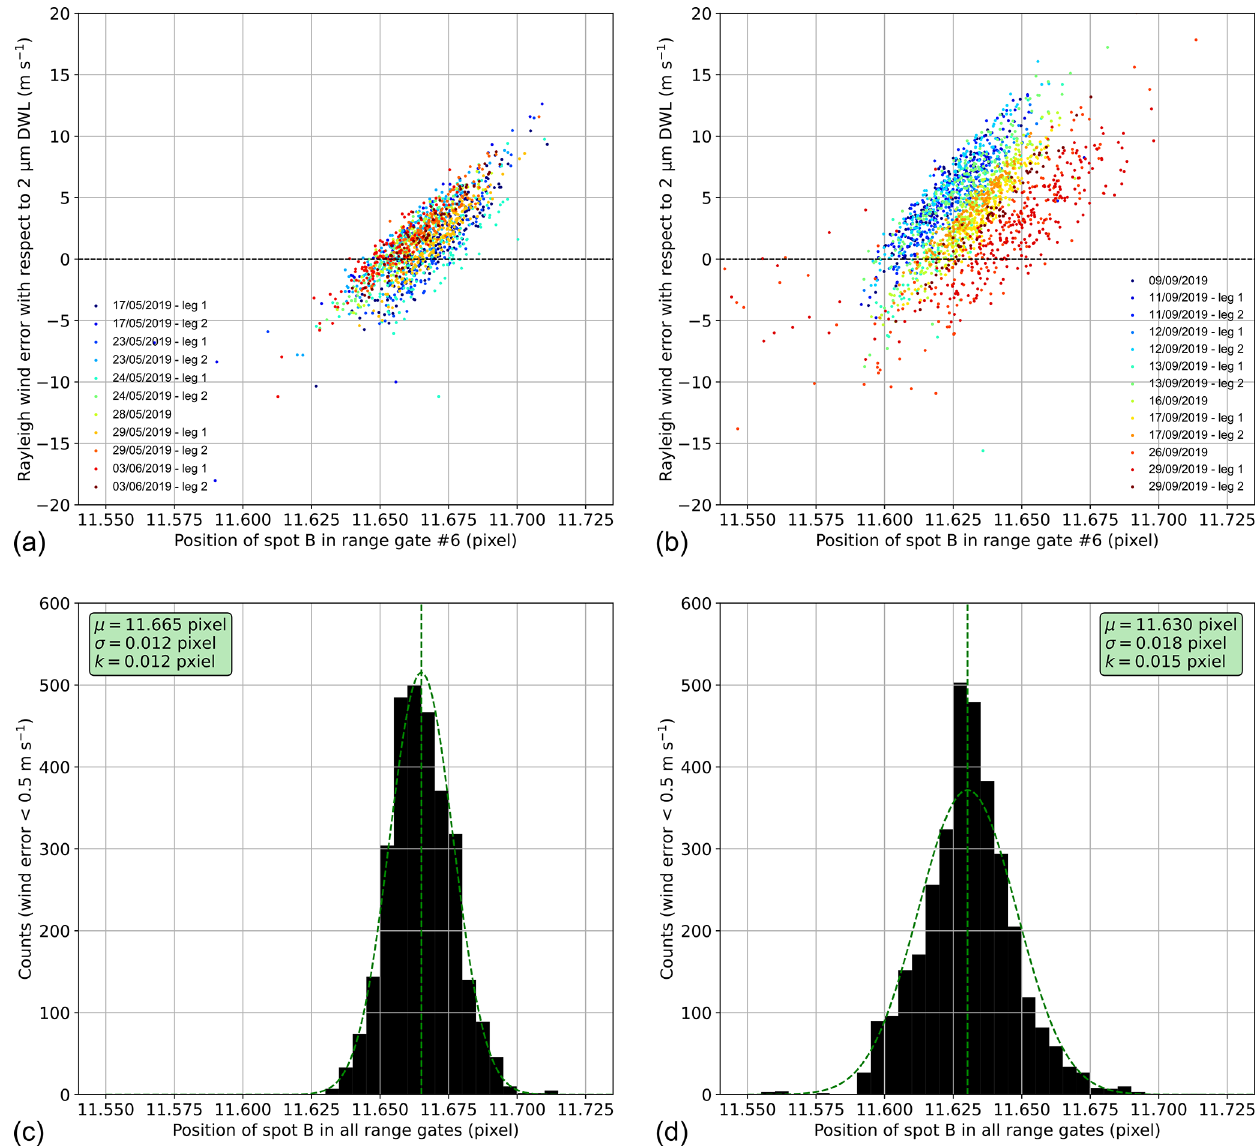
Figure 7. A2D Rayleigh wind error with respect to the 2µm DWL in dependence on the position of spot B in range gate no. 6 for (a) the entire AVATARE campaign and (b) the entire AVATARI campaign (except for the underflights on 22 and 23 September 2019). The scatters are colour-coded according to the different Aeolus underflight legs. Panels (c) and (d) show histograms of spot positions from all range gates for which the wind error is < ± 0 . 5ms − 1 (bin size of 0.005